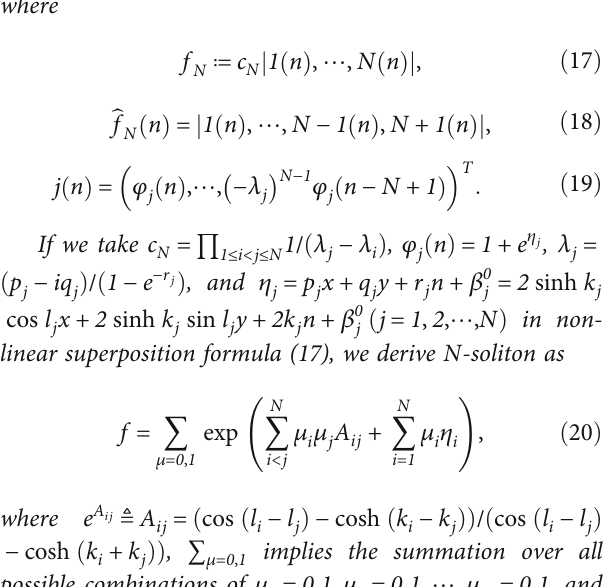
Figure 5: The degeneration of 2-breather (23) with β (c) α 1 = α 2 = 0 : 05 , and (d)